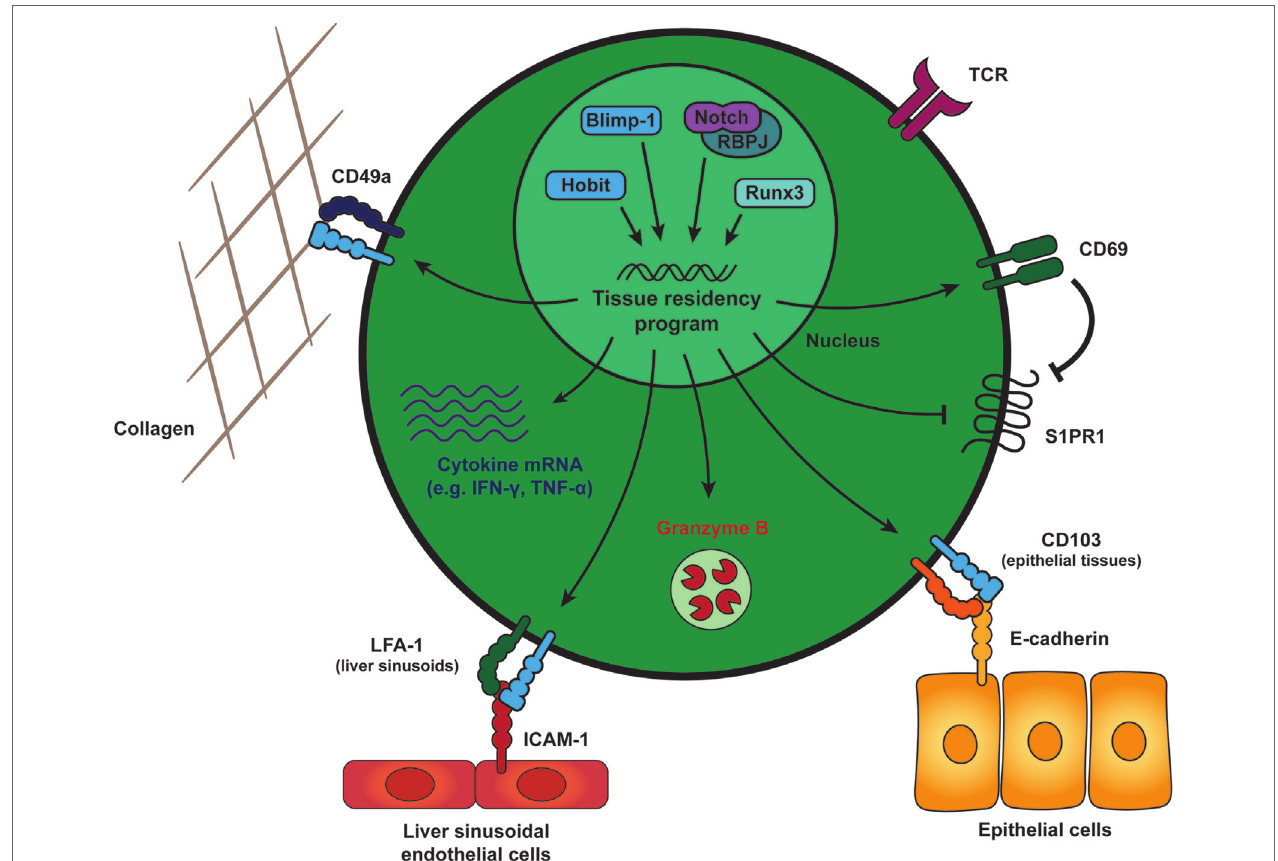
FigURe 1 | General features of tissue-resident memory CD8 T (T RM ) cells. Generation and maintenance of T RM cells is regulated by a distinct set of transcription factors, including Runx3, Blimp-1, and its homolog of Blimp-1 in T cells as well as the transcriptional activator Notch. These transcription factors instruct a tissue-residency program that allows for the long-term retention and maintenance of T RM cells within peripheral tissues. T RM cells across tissues maintain expression of CD69, which promotes tissue residency by interfering with spingosine-1 phosphate receptor (S1PR1) function. S1PR1 mediates egress of T cells into the circulation and its downregulation is a core characteristic of T RM cells. In many tissues, T RM cells also express high levels of CD49a, an adhesion molecule binding to collagen (in complex with β 1 integrin) to establish tissue residency. The α E integrin CD103 is expressed by mucosal T RM cells and may contribute to tissue retention by interaction with E-cadherin on the surrounding epithelial cells. In liver sinusoids, local T RM cells upregulate LFA-1, which supports their tissue residence by binding to ICAM-1 on liver sinusoidal endothelial cells. In addition to these adhesion molecules, T RM cells in many tissues are characterized by elevated transcript levels encoding for pro-inflammatory cytokines, e.g., IFN- γ and TNF- α , and protein expression of the cytotoxic serine protease granzyme B. Abbreviations: Runx3, Runt-related transcription factor 3; Blimp-1, B lymphocyte-induced maturation protein-1; Hobit, homolog of Blimp-1 in T cells; RBPJ, recombining binding protein suppressor of hairless; LFA-1, lymphocyte function-associated antigen-1; ICAM-1, intercellular adhesion molecule 1; IFN- γ , interferon γ ; TNF- α , tumor necrosis factor α